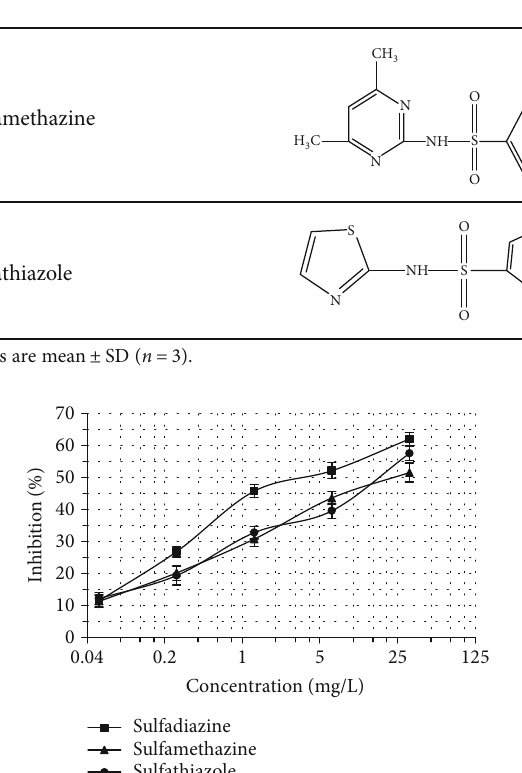
Figure 5: Cross-reactivity of three types of